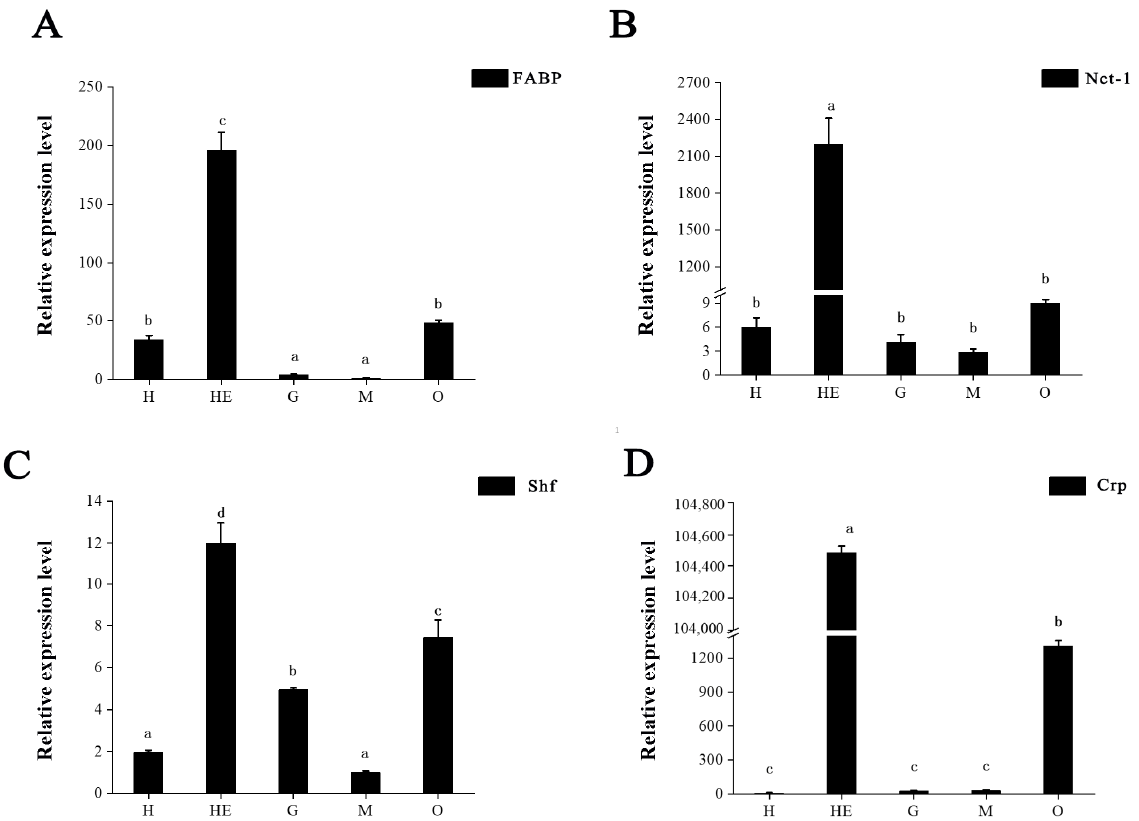
Figure 9. mRNA expression profiles of 4 proteins in different tissues. ( A ) FABP , ( B ) Nct-1 , ( C ) Shf , ( D ) Crp . H: heart, G: gill, HE: hepatopancreas, O: ovary, M: muscle. Data are shown as mean ± SD ( n = 3). Statistical analyses were performed with one-way ANOVA analysis. Lowercase letters on the columns (a, b, c, and d) denote significant differences ( p < 0.05) and same letters mean no significant difference ( p > 0.05).